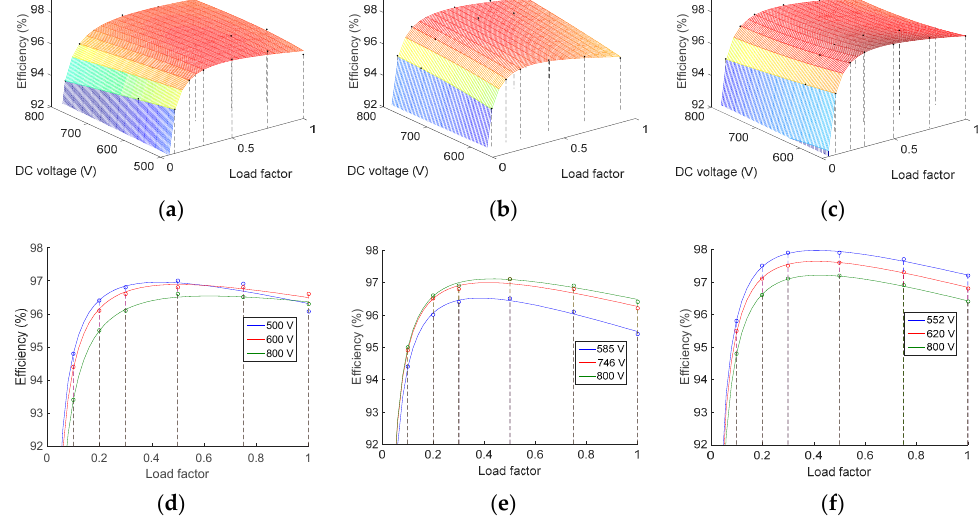
Figure 9. Efficiency surfaces and detail of curves for three values of the DC voltage calculated by means of the Driesse model. ( a ) and ( d ) Perfect Galaxy International Ltd EQX0250UV480TN. ( b ) and ( e ) Power-One ULTRA-750-TL-OUTD-4-US. ( c ) and ( f ) Power Electronics FS0900CU.